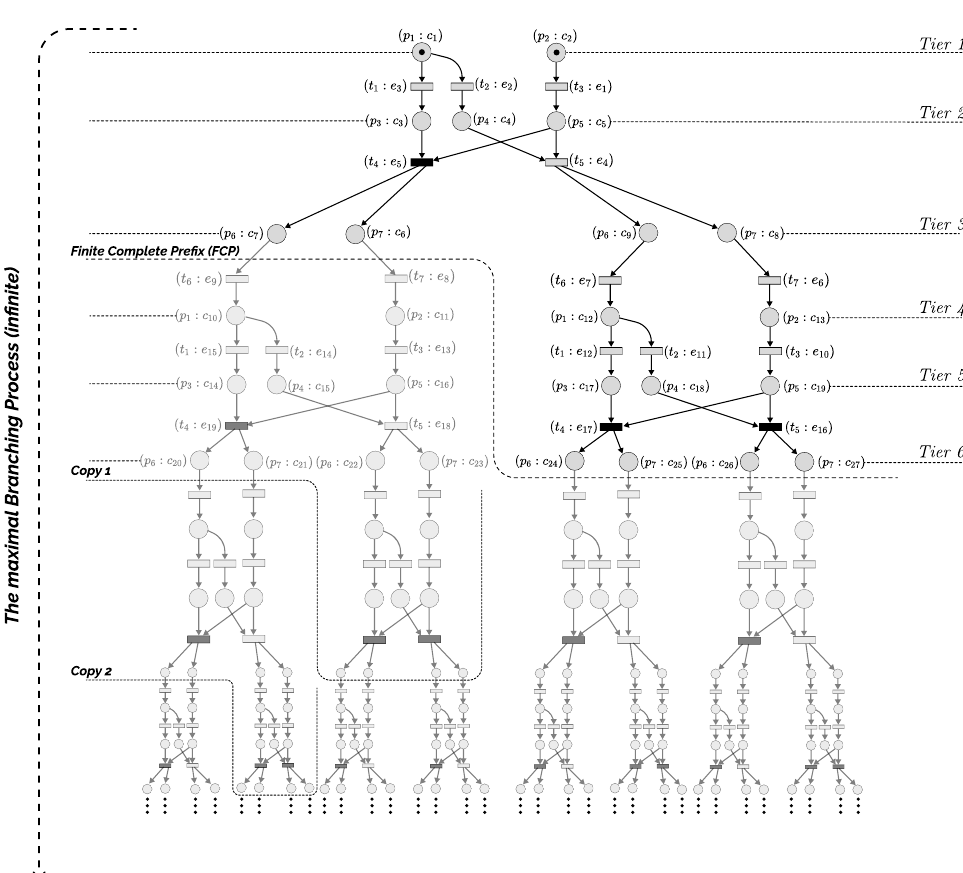
Figure 6. An illustration representing the truncation process of the final complete prefix of the maximal branching process in Figure